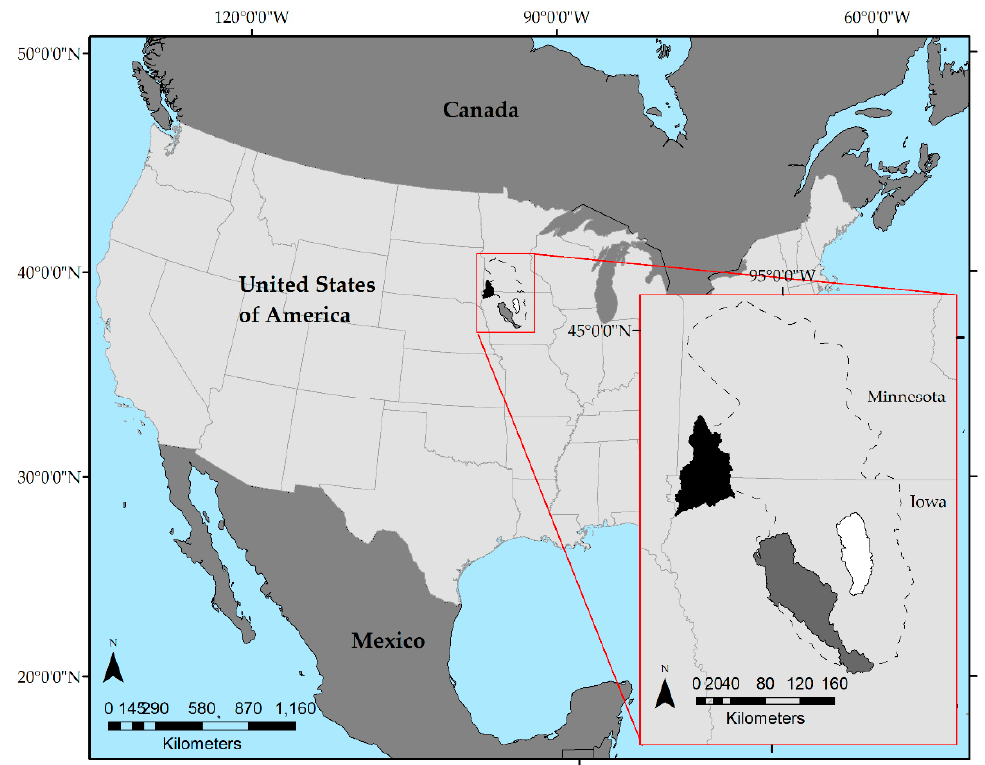
Figure 1. Rock River watershed ( black ), North Raccoon River watershed ( dark grey ), and Boone River watershed ( white) located in southwestern Minnesota and northwest and central Iowa, USA where off-channel restoration is currently being conducted to support the conservation of Topeka Shiner populations ( Notropis topeka ). The Des Moines Lobe ecoregion is outlined by the dashed line.